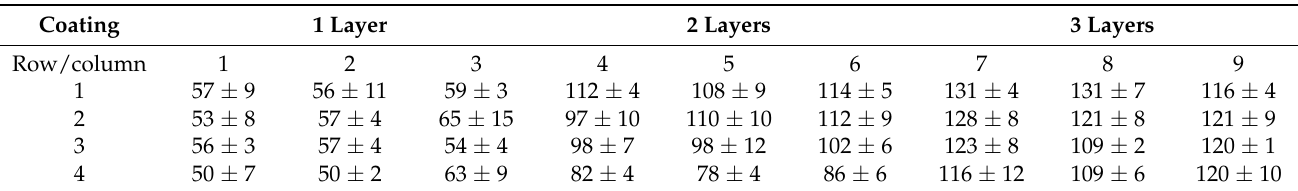
Table 2. Comparison of mean thickness values t ( µ m) of the coating at 36 test points on the large steel sheet with the blue